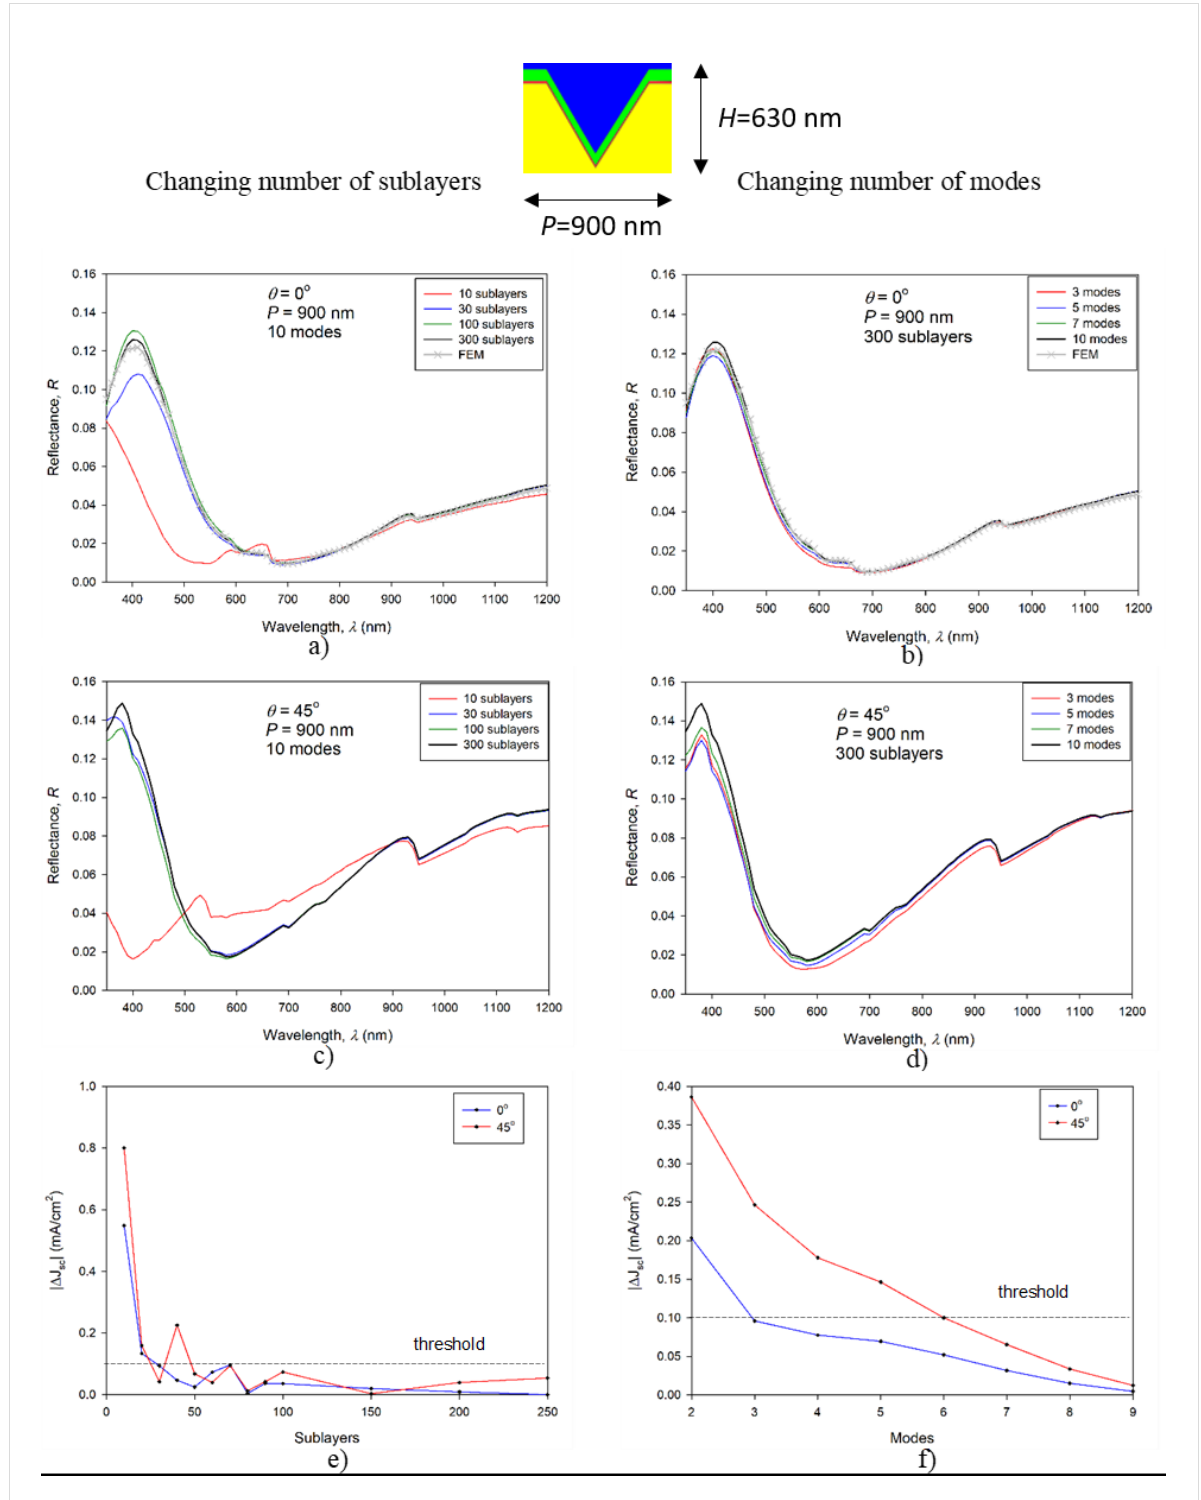
Figure 5: Analysis of the RCWA convergence for the nanoscale textures. All graphs on the left hand side correspond to the results of the variation in the number of sublayers with a fixed number of modes (ten modes) whereas the right hand side graphs represent the results of the variation in the number of mode with a fixed number of sublayers (300 sublayers). The top two graphs (a, b) correspond to an incident angle of 0° whereas the middle two (c, d) are for the incident angle of 45°. The bottom two graphs (e, f) quantify deviations between RCWA results using the | Δ J SC |